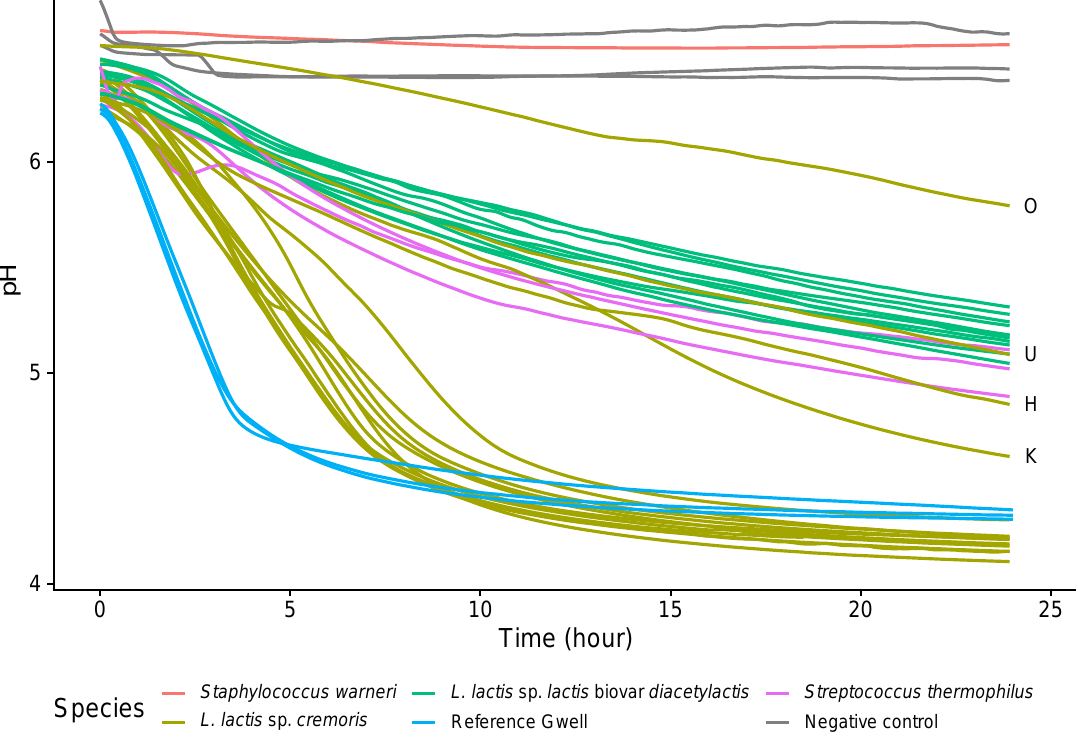
Figure 5. Acidification curves for the 26 isolated and selected strains inoculated (5% ( v / v )) in sterilized skimmed milk incubated at 30 ◦ C for 24 h. The pH curves are colored according to the species. Acidification curves of reference Gwell are shown in blue. Atypical slow-acidifier L. lactis sp. cremoris strains are labeled with their clone ID